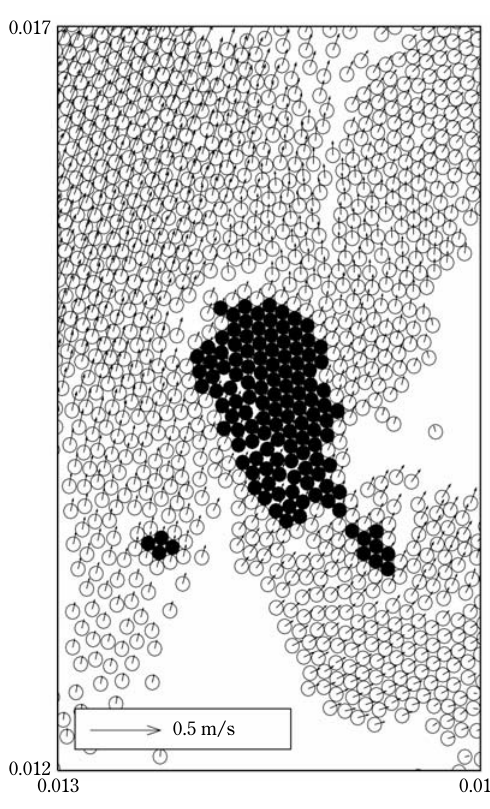
Fig. 5 The details of a size reduction mechanism where the ‘tail’ of a solid block made from primary cohesive (black) parti- cles is about to be torn apart by the fluidizing cohesionless (white) particles at t (cid:1) 4s and u/u mf (cid:1) 4.8. The ratio of the maximum cohesive force at z min to particle weight is 338.